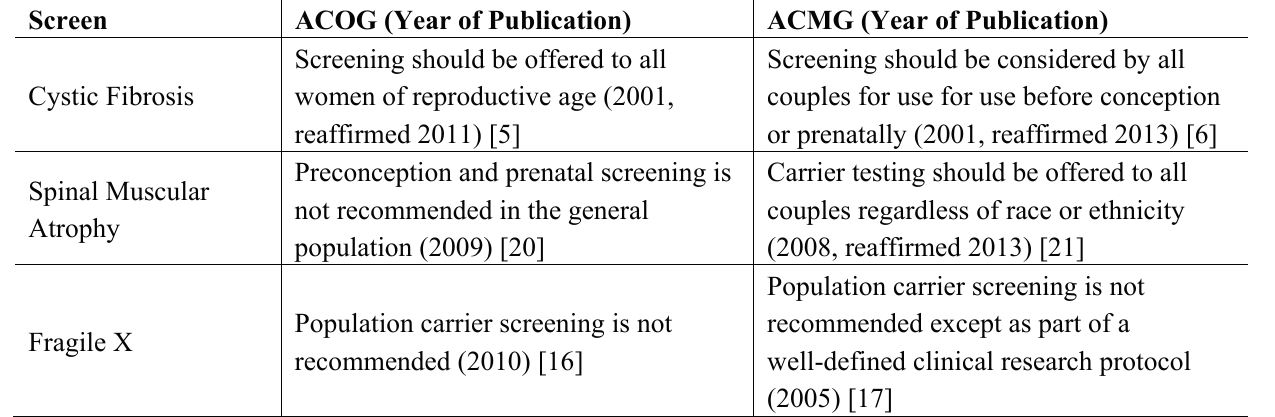
Table 3. Summary of currently available ACOG and ACMG screening